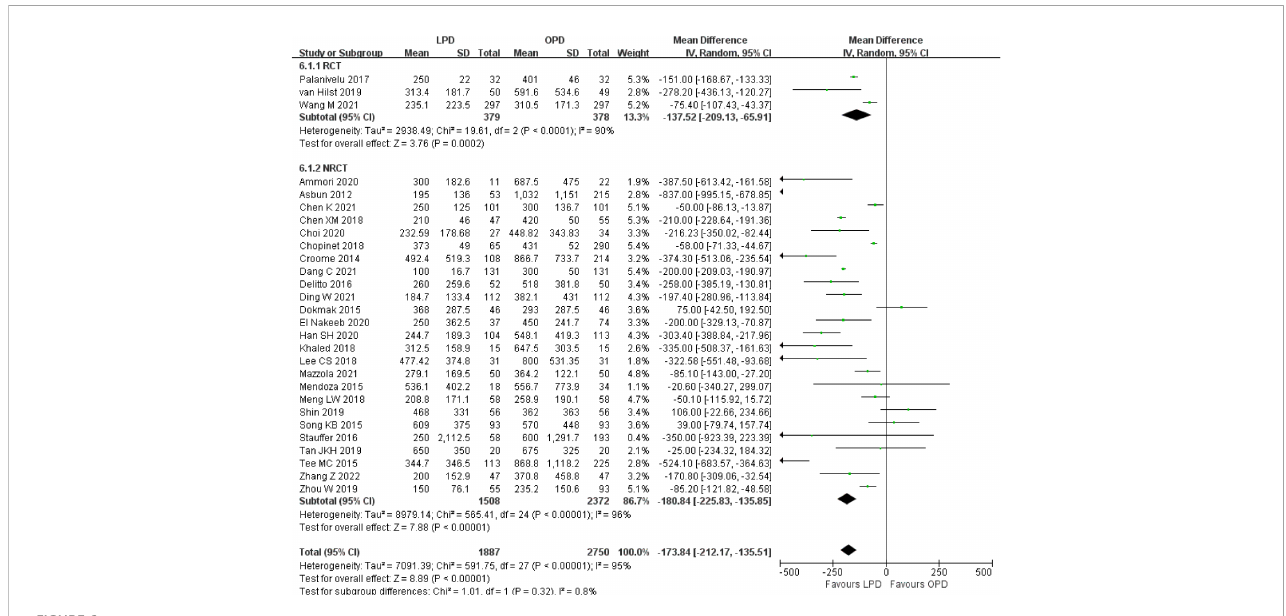
FIGURE 6 Forest plot of comparison between LPD and OPD on estimated blood loss. LPD, laparoscopic pancreaticoduodenectom; OPD, open